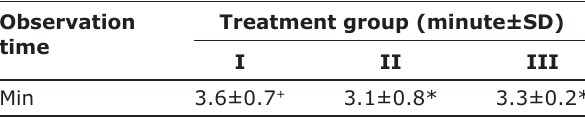
Table-4: Observation of subjective bleeding test.